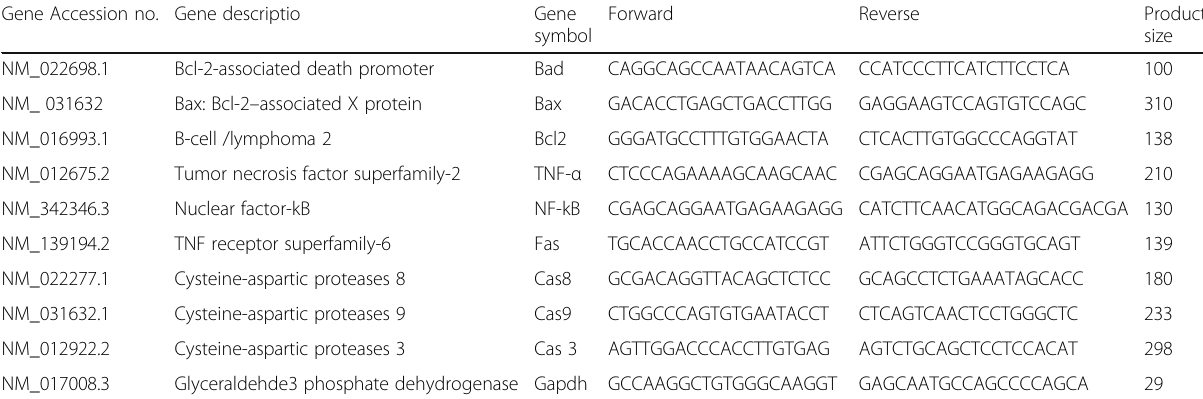
Table 2 The list of primers used for